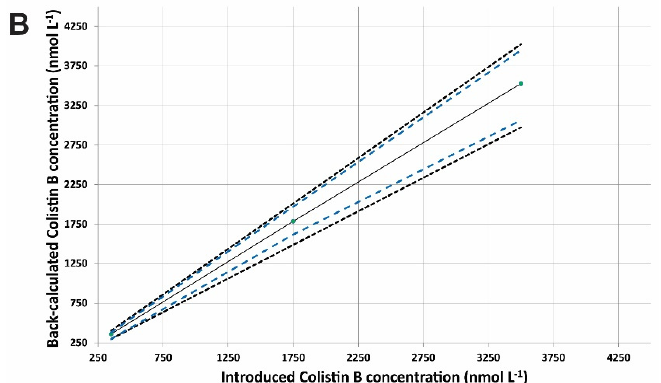
Figure 6. Linearity profile of ( A ) Colistin A and ( B ) Colistin B. The plain blank line corresponds to the identity line ( Y = X ), the blue dashed line represents the accuracy profile ( β -ETI), and the dotted curves illustrate the acceptance limits λ ±15% expressed in nmol ∙ L − 1 .